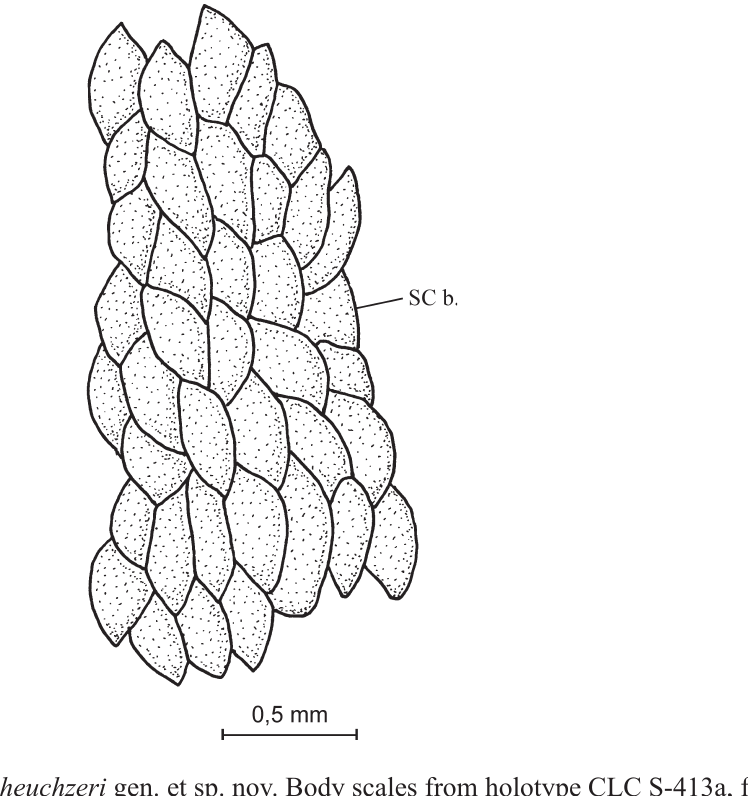
Fig. 14. Monocerichthys scheuchzeri gen. et sp. nov. Body scales from holotype CLC S-413a, from the dorsal region near the